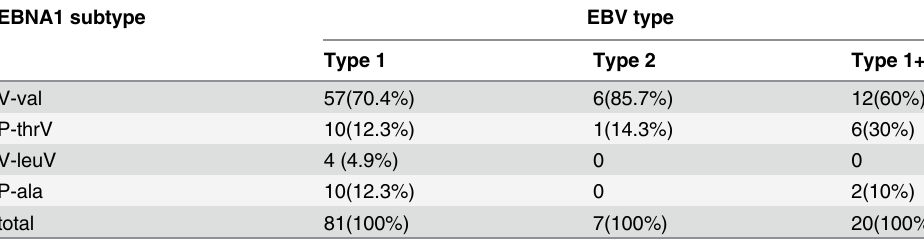
Table 3. Association of EBNA1 subtypes and EBV types in the EBV isolates of